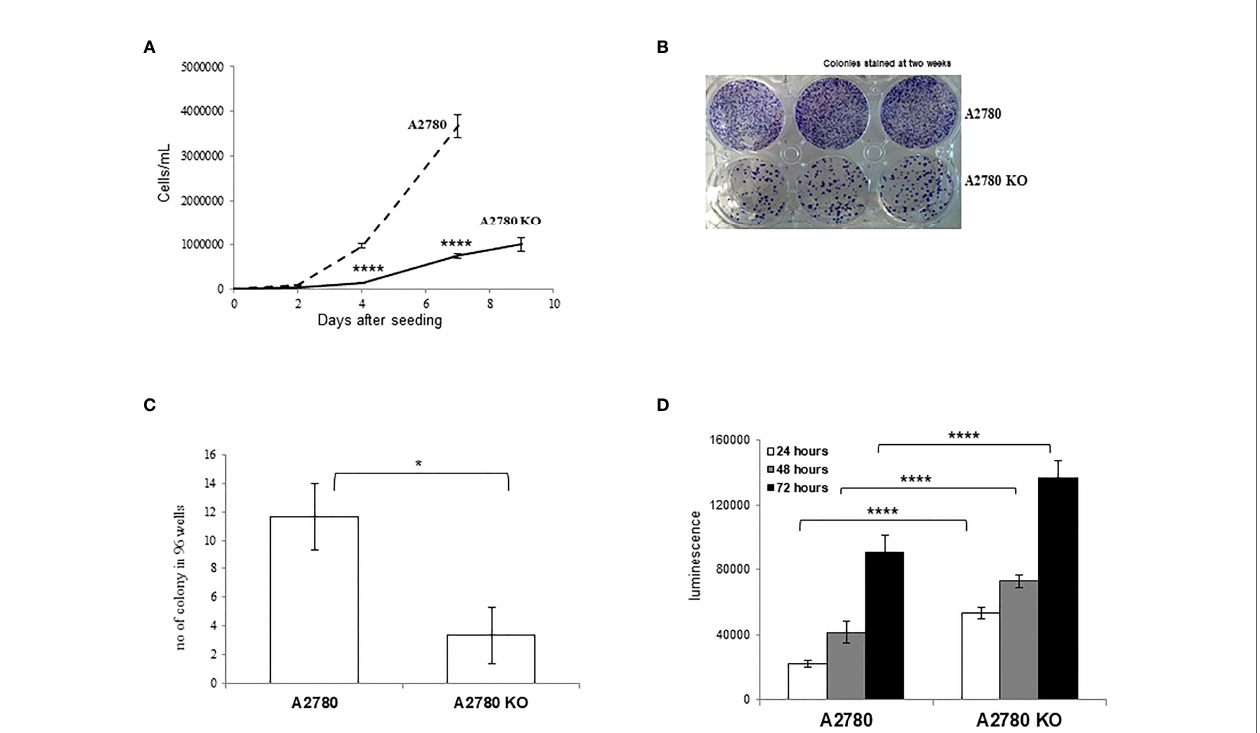
FIGURE 2 | Biological characterization of A2780 and A2780 CDK12 KO cells. (A) Growth curves for cells/mL ( — A2780 cells; —— A2780 CDK12 KO cells) at different times from seeding. Data are the mean ± SD of three replicates and each experiment was performed three times. t-test was used for statistical analysis (****p < 0.0001). (B) Colony assays performed in six-wells plates of CDK12 WT (upper wells) and KO (lower wells) cell lines. Cells were stained two weeks after seeding. The results shown are representative of three independent experiments. (C) Number of colonies in 96-wells plates. Data are the mean ± SD of three replicates done three times (*= p<0.0082). (D) Apoptotic signals 24 (white), 48 (grey) and 72 (black) hours from the seeding. Data are the mean ± SD of six replicates done three times. For statistical analysis, two-way ANOVA, followed by Tukey ’ s test was used to compare CDK12 KO with the WT cell line at each time (****p <